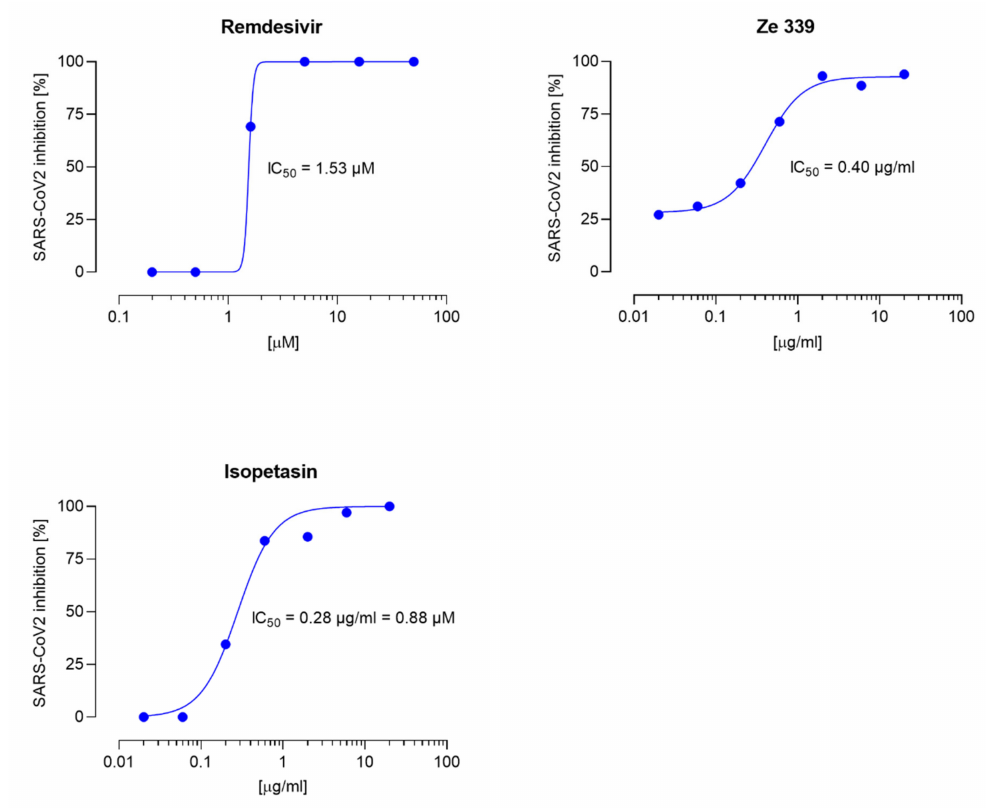
Figure 4. Dose response curves for remdesivir, Ze 339, and isopetasin on the SARS-CoV-2 Delta variant. Cells were infected with 100 pfu of a clinical virus isolate in the presence of the